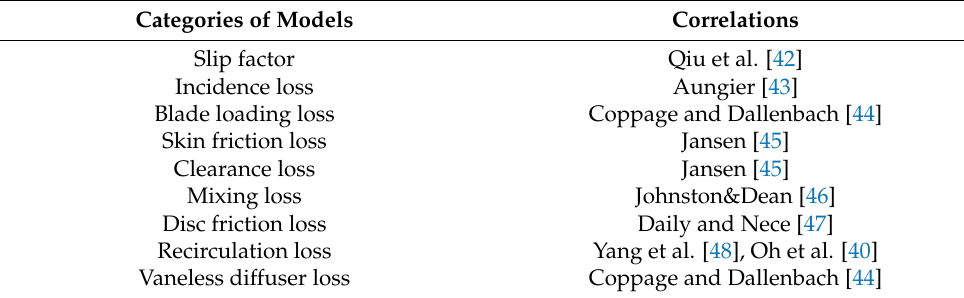
Table 1. Empirical correlations list in centrifugal compressor